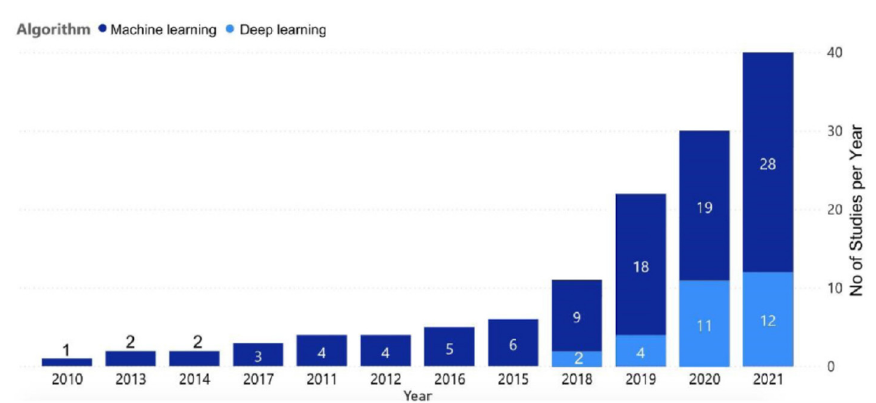
Figure 7. Number of HRV analysis studies using machine or deep learning within one year, from 2010 to 2021. Reprinted with permission from [23].